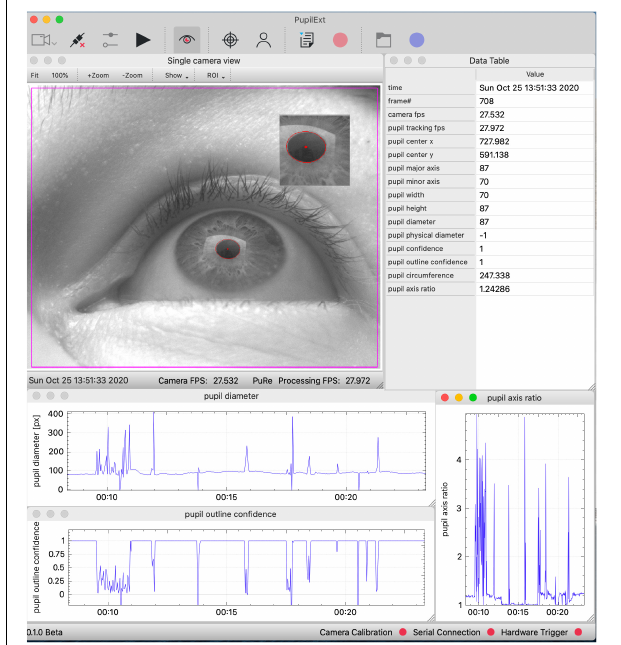
FIGURE 1 | The graphical user interface of the PupilEXT software during a pupil measurement with one connected industrial camera. The measured pupil values are listed in real-time in a table or can be visualized graphically. We provide a selection of six state-of-the-art pupil detection algorithms from the literature. Stereo camera systems can be connected and calibrated seamlessly to acquire the absolute pupil diameter. The accuracy of a pupil measurement or calibration can be verified by implemented